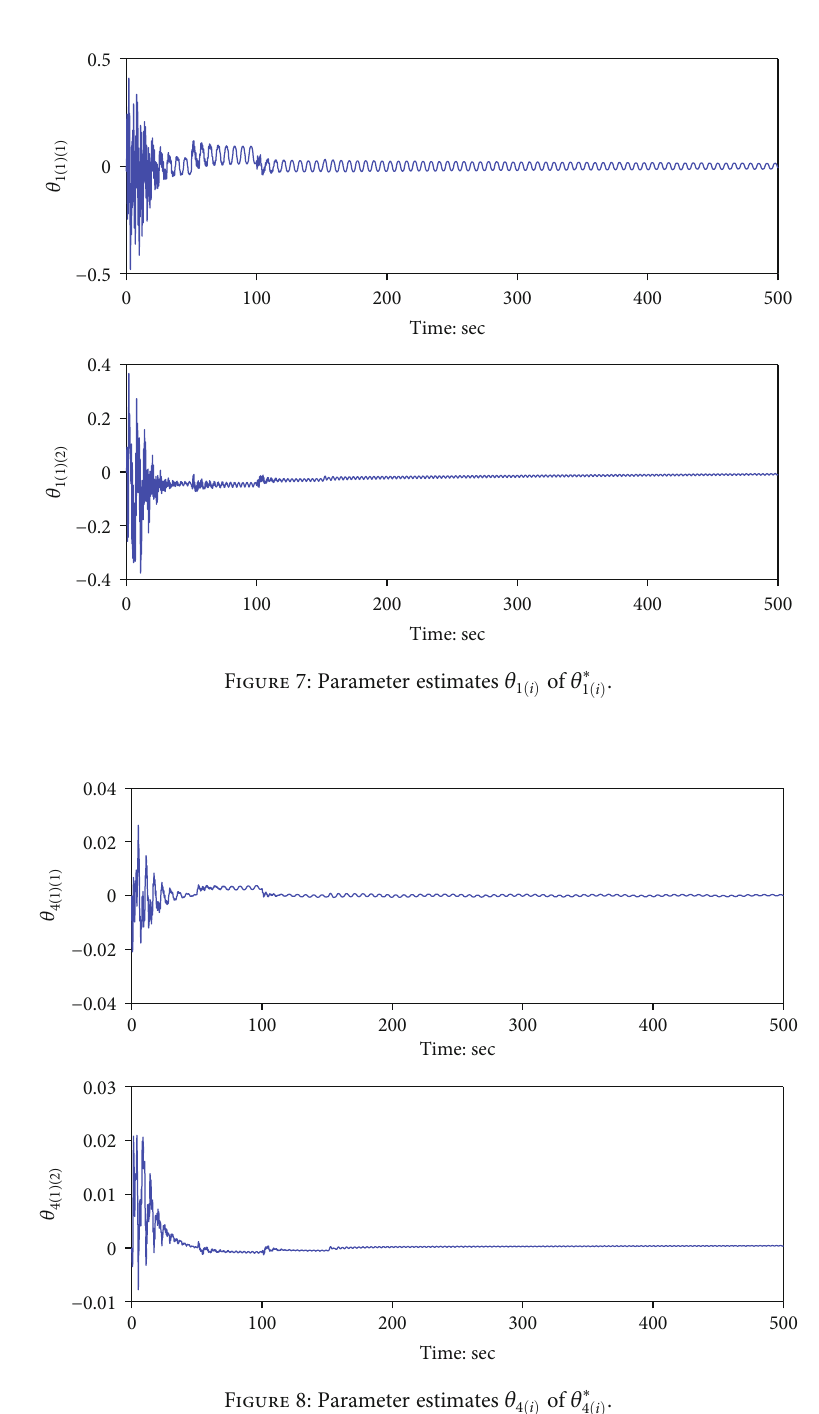
of θ ∗ 4 ð i Þ 4 ð i Þ